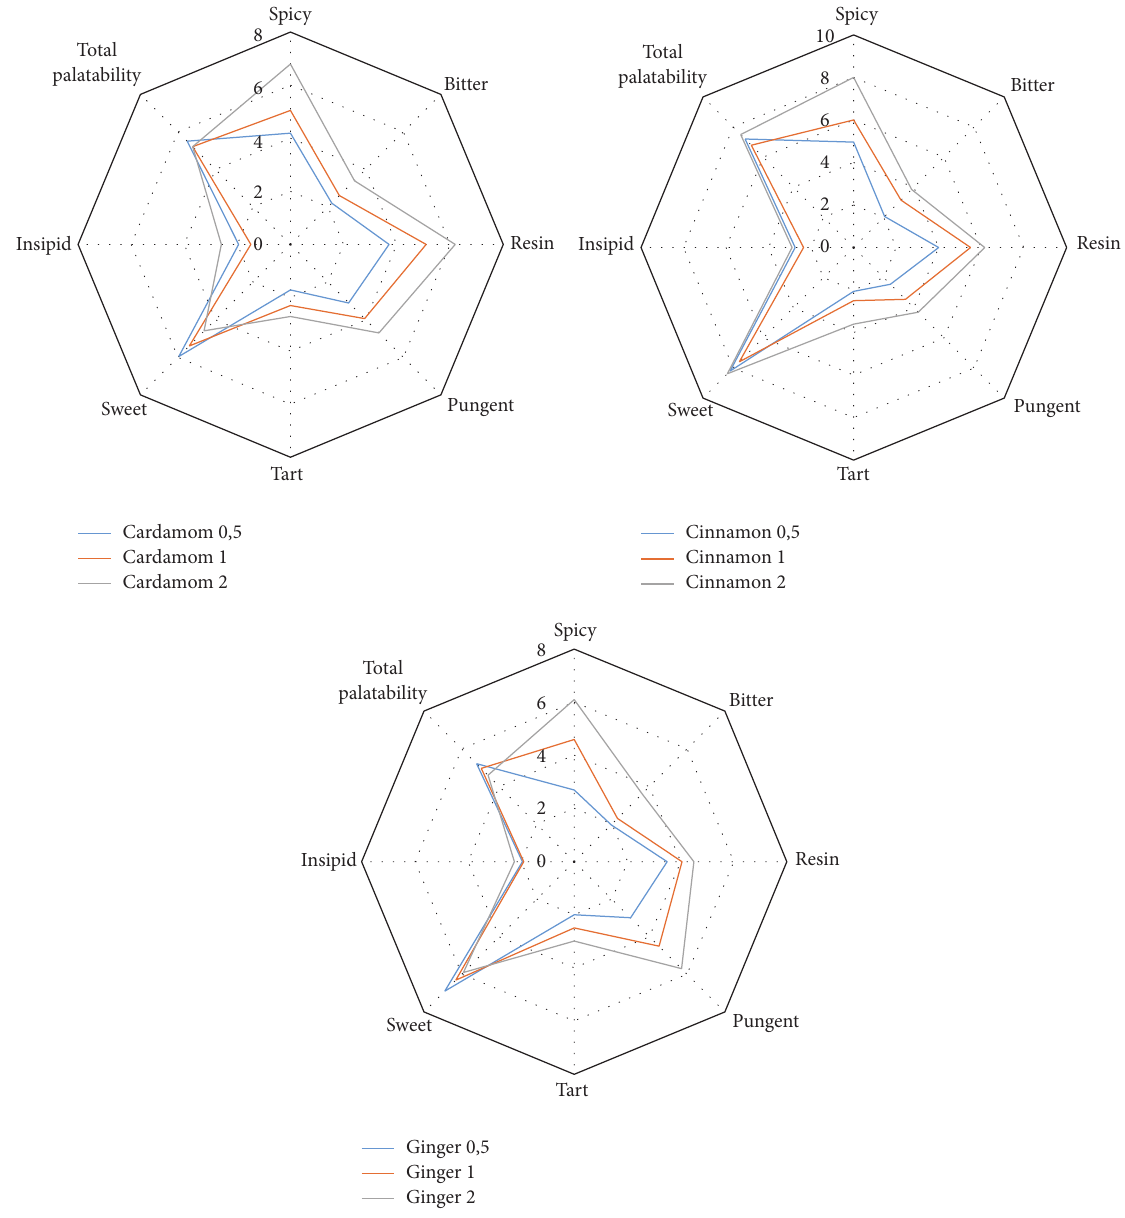
Figure 1: The results of the taste attributes of honey with spices (scale 0–10). Source: own